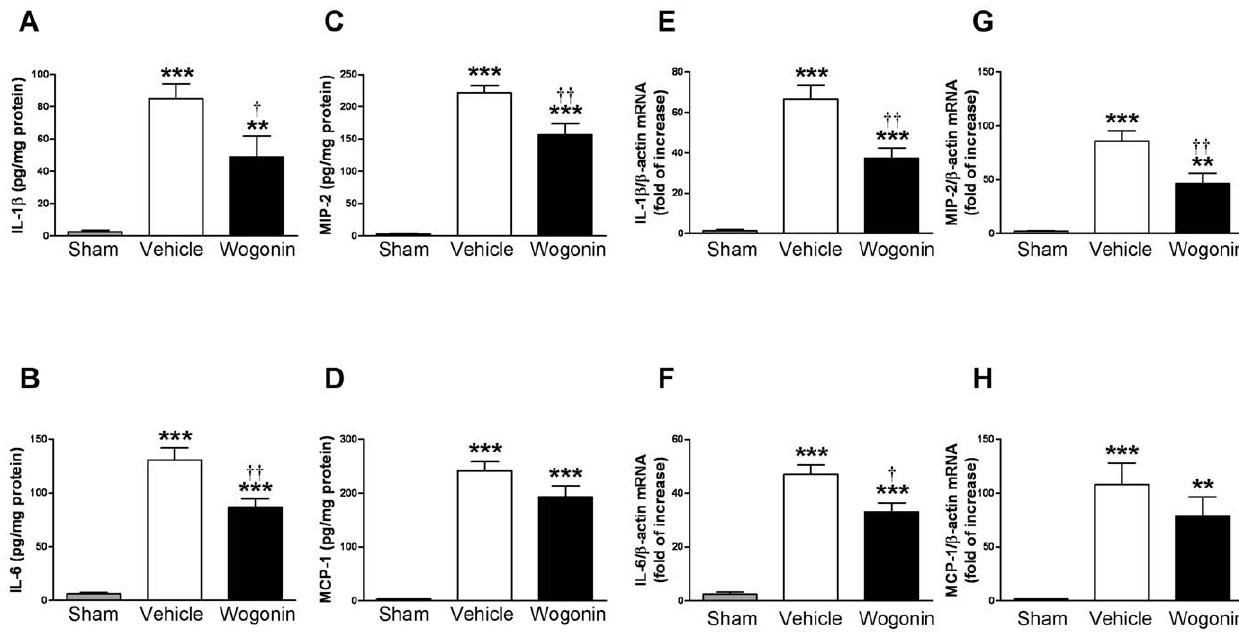
Figure 5. Effects of 40 mg ? kg 2 1 wogonin treatment on protein and mRNA expression of cytokines and chemokines. ( A, B, C, D ) Bar graphs of interleukin (IL)-1 b , IL-6, macrophage inflammatory protein (MIP)-2, and monocyte chemoattractant protein (MCP)-1 protein concentrations in the ipsilateral cortices of sham control, vehicle-treated, and 40 mg ? kg 2 1 wogonin-treated mice at day 1 post-injury. Wogonin significantly attenuated injury-induced increases in IL-1 b , IL-6, and MIP-2 protein concentrations, but had no effect on MCP-1 protein concentration compared with vehicle-treated TBI mice. ( E, F, G, H ) Bar graphs demonstrating IL-1 b , IL-6, MIP-2, and MCP-1 mRNA expression in the ipsilateral cortices of sham control, vehicle-treated, and 40 mg ? kg 2 1 wogonin-treated mice 6 h post-injury. Wogonin significantly inhibited injury-induced expression of IL-1 b , IL- 6, and MIP-2 mRNA in the ipsilateral cortices. There was no significant difference in MCP-1 mRNA transcript levels between the wogonin-treated and vehicle-treated groups of mice subjected to TBI. Values are presented as means 6 SEM; ** P , 0.01, *** P , 0.001 versus sham control, and { P , 0.05, {{ P , 0.01 for wogonin-treated mice versus vehicle-treated TBI mice (n=7 mice/group). (Fig. 6D). Wogonin treatment significantly reduced the injury- induced increased nuclear levels of NF- k B to 55.3% ( P , 0.05) of vehicle-treated brains at day 1 post-TBI (Fig. 6E). We further used electrophoretic mobility shift assays (EMSAs) to examine whether wogonin affected the DNA binding activity of NF- k B. NF- k B was present at low levels in sham control brains. Compared with the sham group, NF- k B binding activity was significantly increased in the vehicle-treated TBI group at day 1 post-TBI (Fig. 6F).